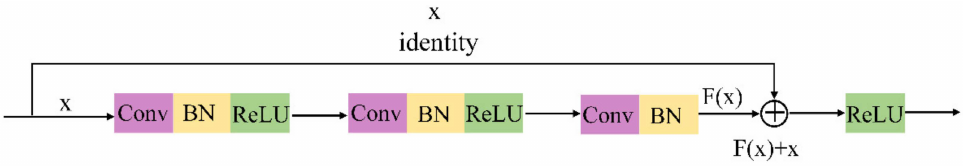
Figure 3. Architecture of the residual structure. The x represents the input